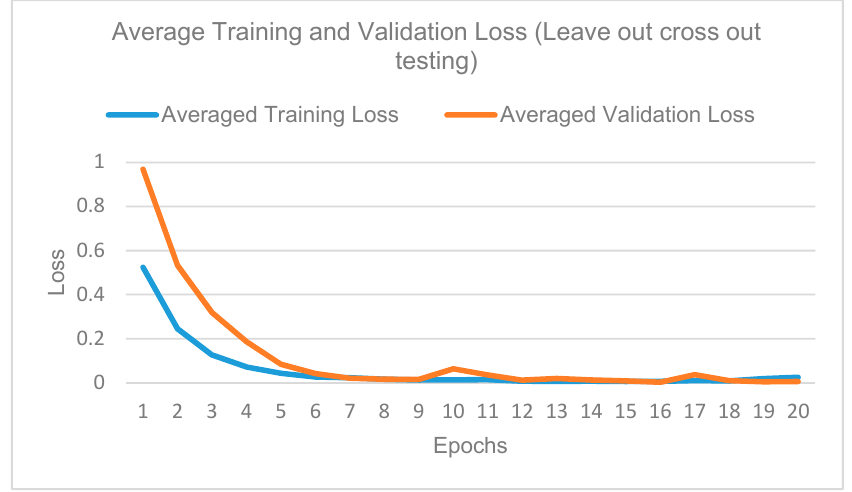
Figure 13. Training and validation curve for PMFE-SN on leave one cross out testing.